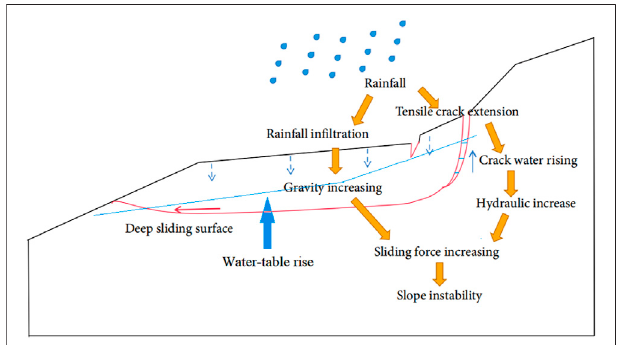
FIGURE 6 | Schematic of hydraulic driving